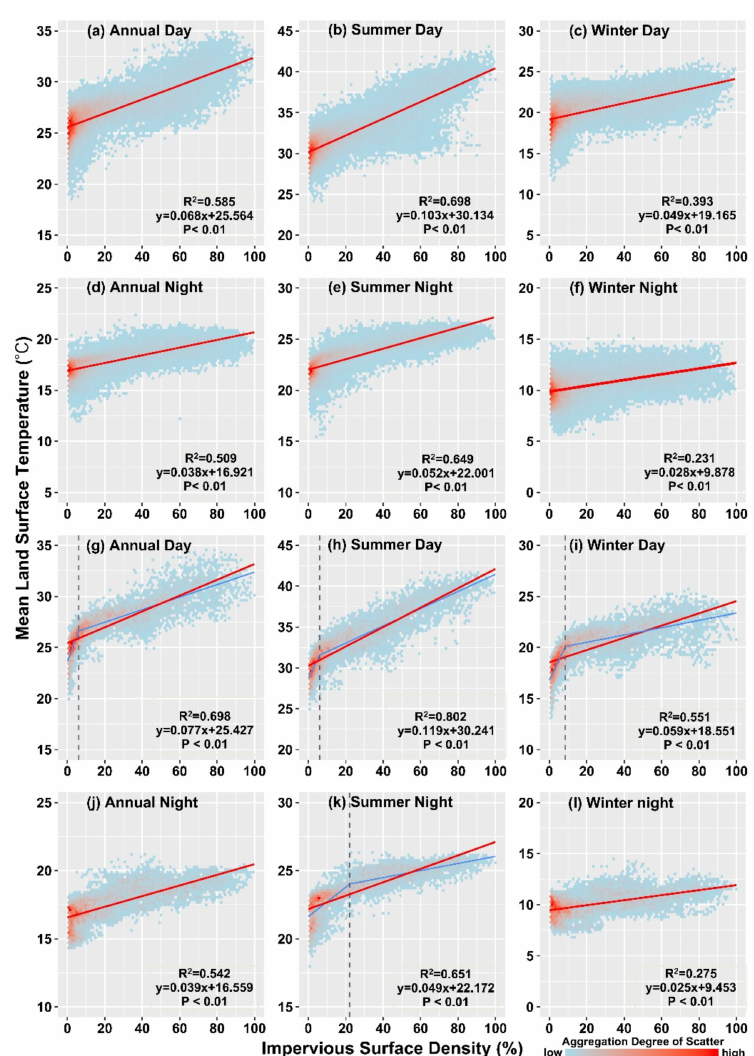
Figure 10. Relations between the density of the impervious surface area and the LST across the PRD. ( a – f ): Relations between the density of the impervious surface area and respectively the annual daytime LST, summer daytime LST, winter daytime LST, annual nighttime LST, summer nighttime LST and winter nighttime LST across the PRD; ( g – l ): relations between the density of the impervious surface area and respectively the annual daytime LST, summer daytime LST, winter daytime LST, annual nighttime LST, summer nighttime LST, and winter nighttime LST across the Guangzhou city. Red line shows linear trends for the entire series; blue line shows piecewise fitting results. The dashed line shows the time when change point